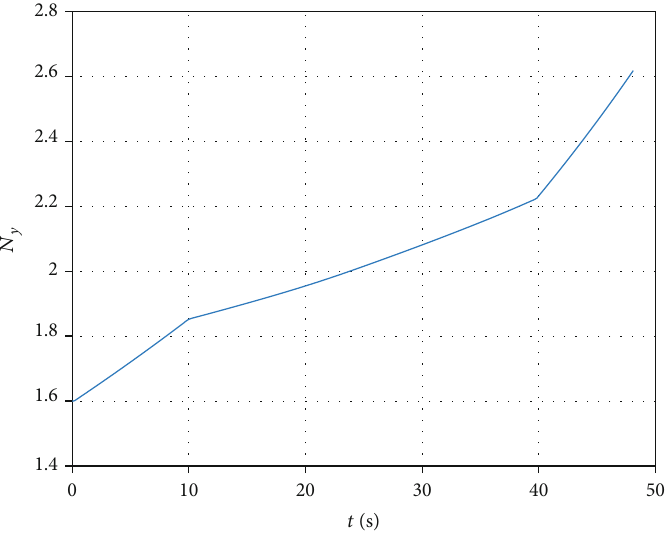
Figure 7: Time histories of the normal load.